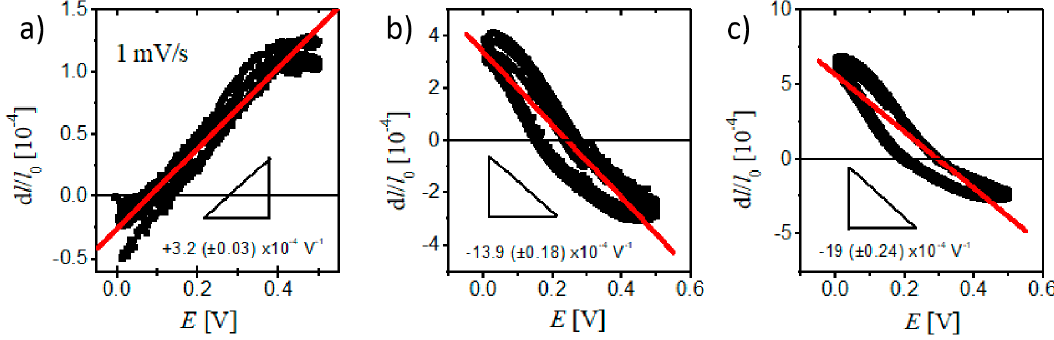
Figure 3. The actuation response as the function of electrode potential at a scan rate of 1 mV/s for npg ( a ), npg + 3MnO 2 ( b ), and npg + 6MnO 2 ( c ). The best linear fit is shown as red lines in the figures.